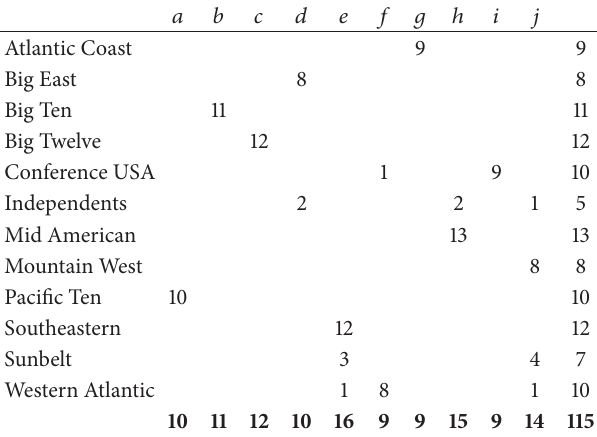
Table 2: The community detection results of the spectral algorithm based on modularity.